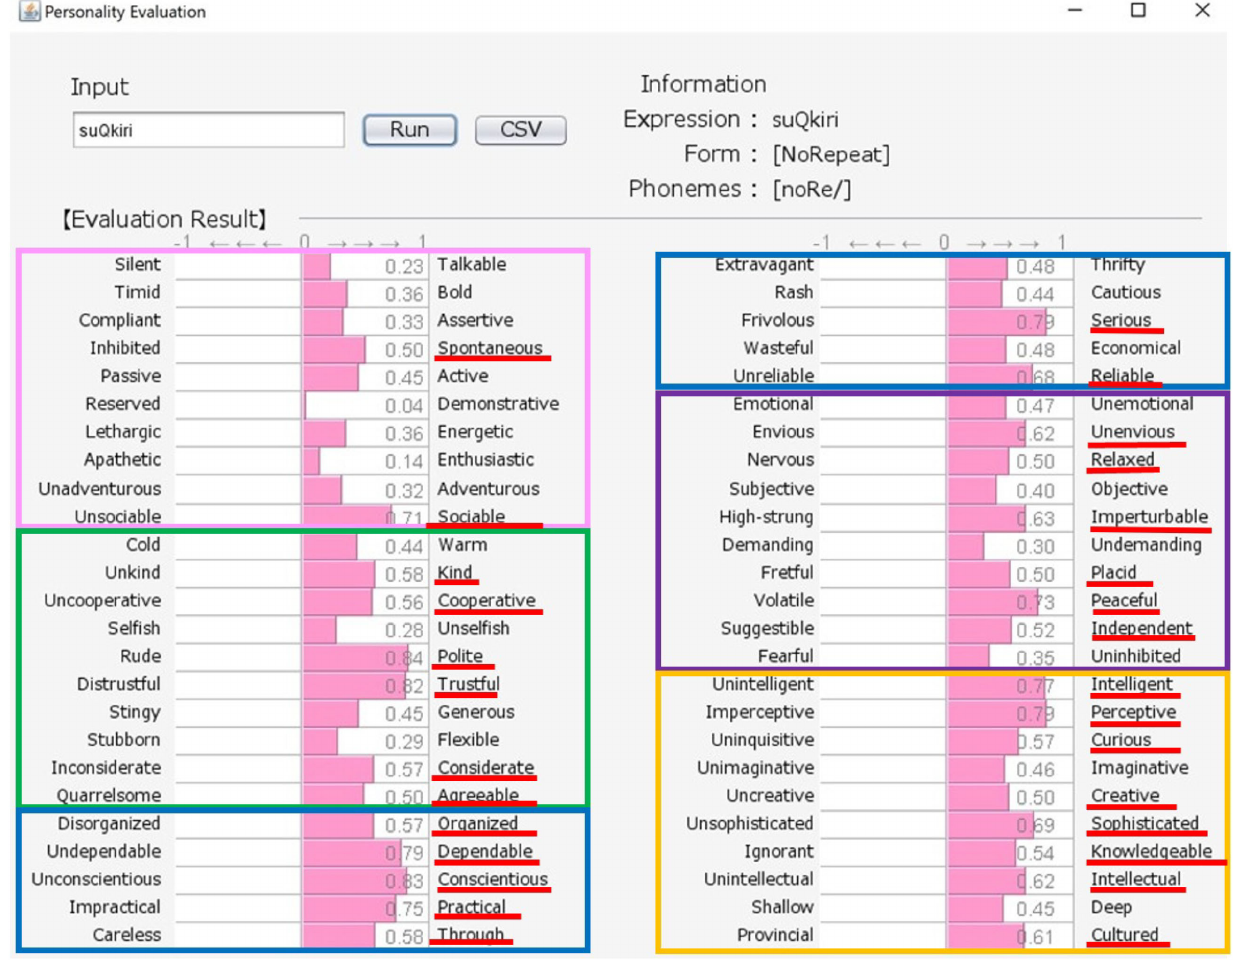
FIGURE 11 | Output for “sukkiri (smart)” personality. The pink, green, blue, purple, and orange frames indicate Extroversion, Agreeableness, Conscientiousness, Neuroticism, and Openness,